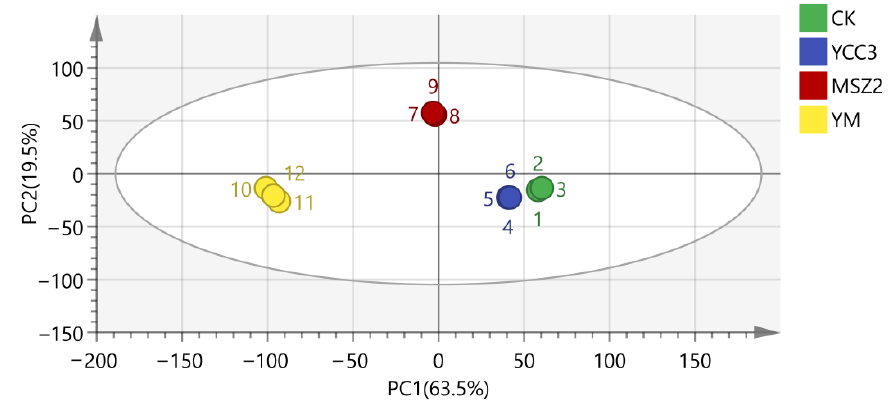
Figure 5. PCA of volatile flavor compounds in four fermented sausages at the end of ripening.